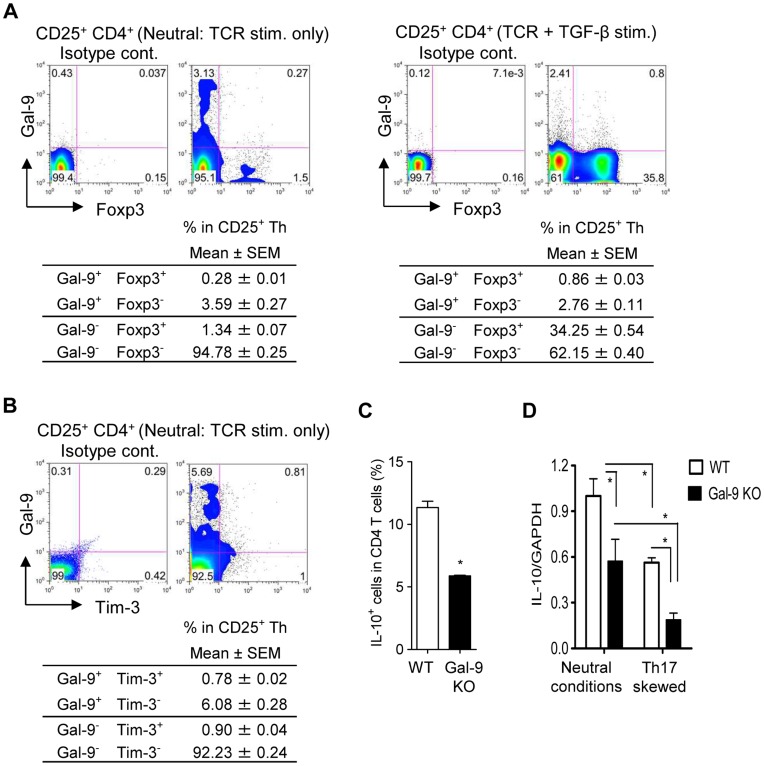
Phenotype of Gal-9+ Th cells.To clearly demonstrate the co-expression of cell-surface Gal-9 with either Foxp3 or Tim-3, highly sensitive Gal-9 staining with biotinylated-anti-Gal-9 antibody plus streptavidin-APC was employed. (A) Naïve CD4 T cells cultured under neutral conditions (left) or Treg-skewing conditions (right) for 4 days were examined for Foxp3 (Treg marker) and cell-surface Gal-9 expressions using flow cytometry. (B) Co-expression analysis of cell-surface Gal-9 and Tim-3 in naïve CD4 T cells cultured under neutral conditions for 4 days. (C) Intracellular IL-10 in naïve CD4 T cells purified from wild-type (WT) or Gal-9 knockout (Gal-9 KO) mice. (D) Naïve CD4 T cells from WT and Gal-9 KO mice were cultured under neutral or Th17-skewing conditions, and IL-10 mRNA expression was measured. Results are shown as the mean ± SEM of triplicate or quadruplicate. Symbol (*) represents significant (p<0.05) differences from the indicated counterparts. Representative data out of at least 2 experiments are shown.